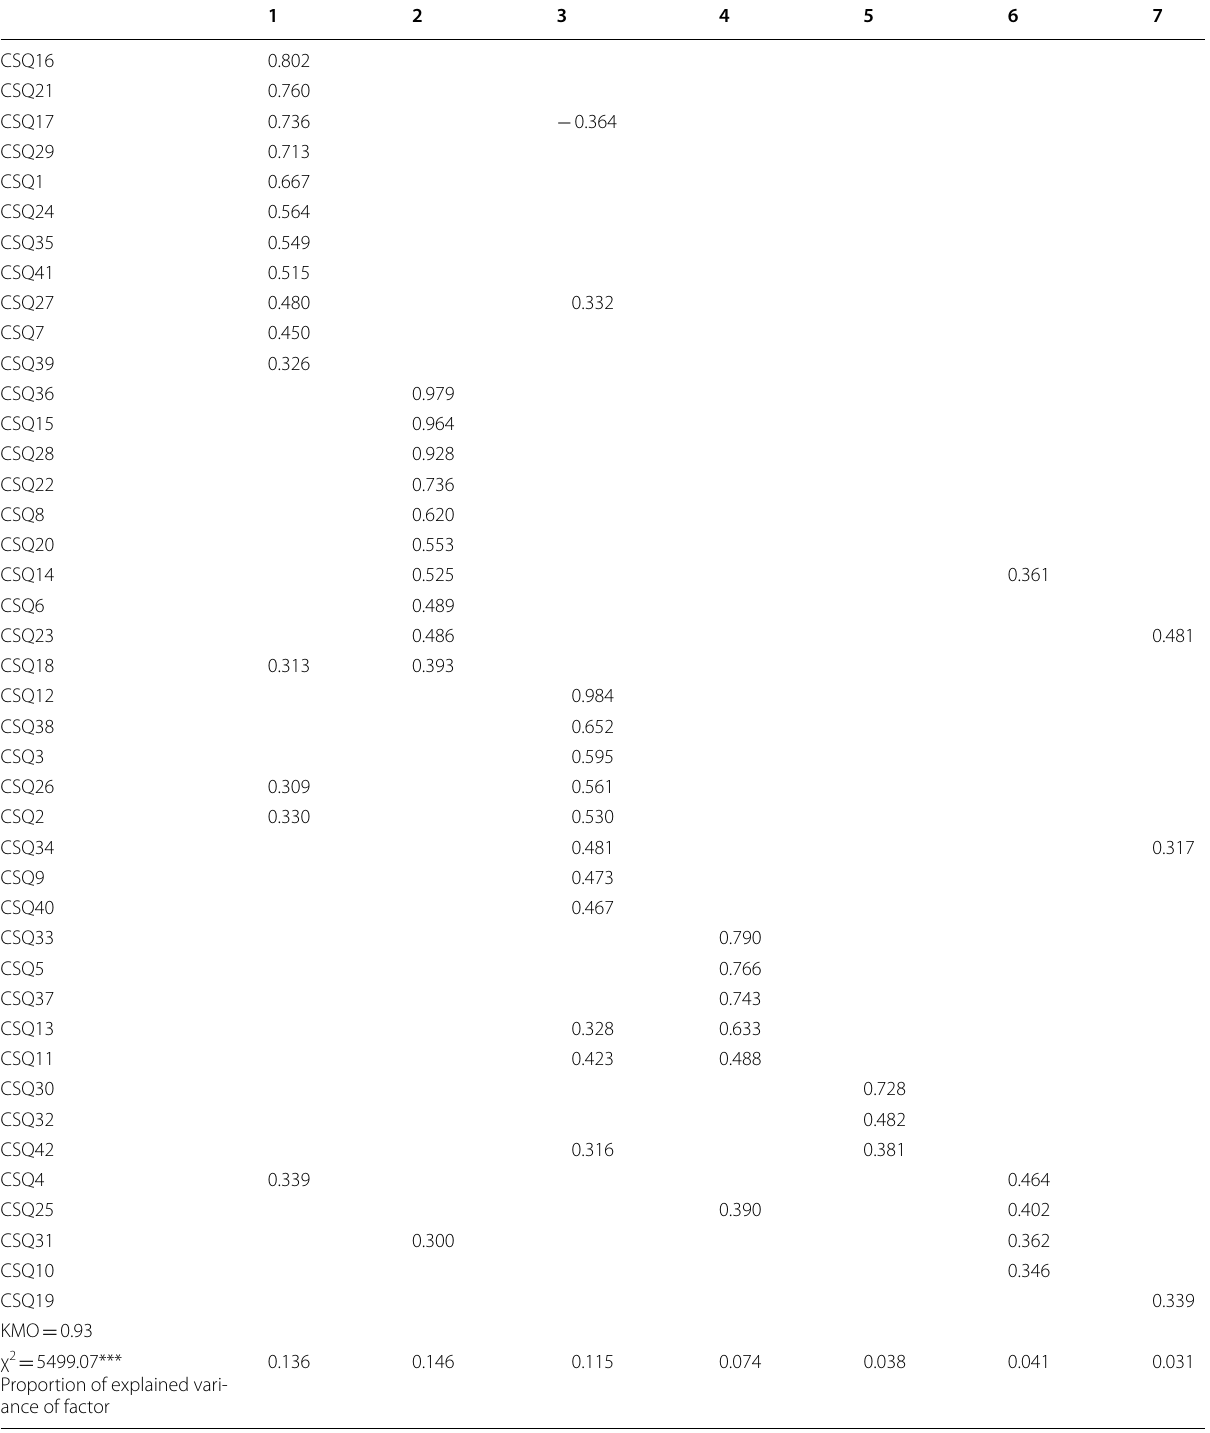
Table 4 Exploratory factor analysis of the Igbo‑CSQ using the Kaiser criterion to determine